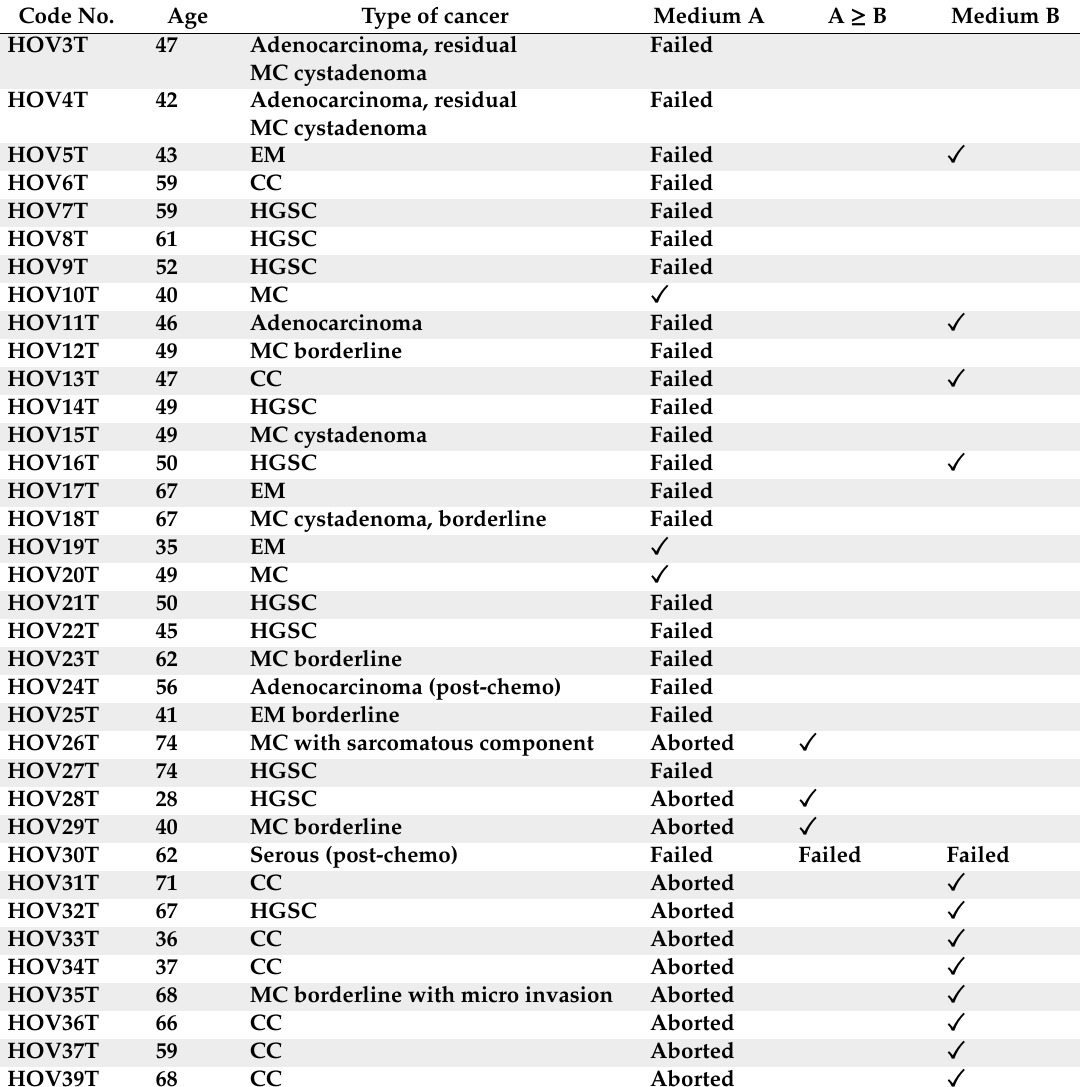
Table 1. Summary of established cell